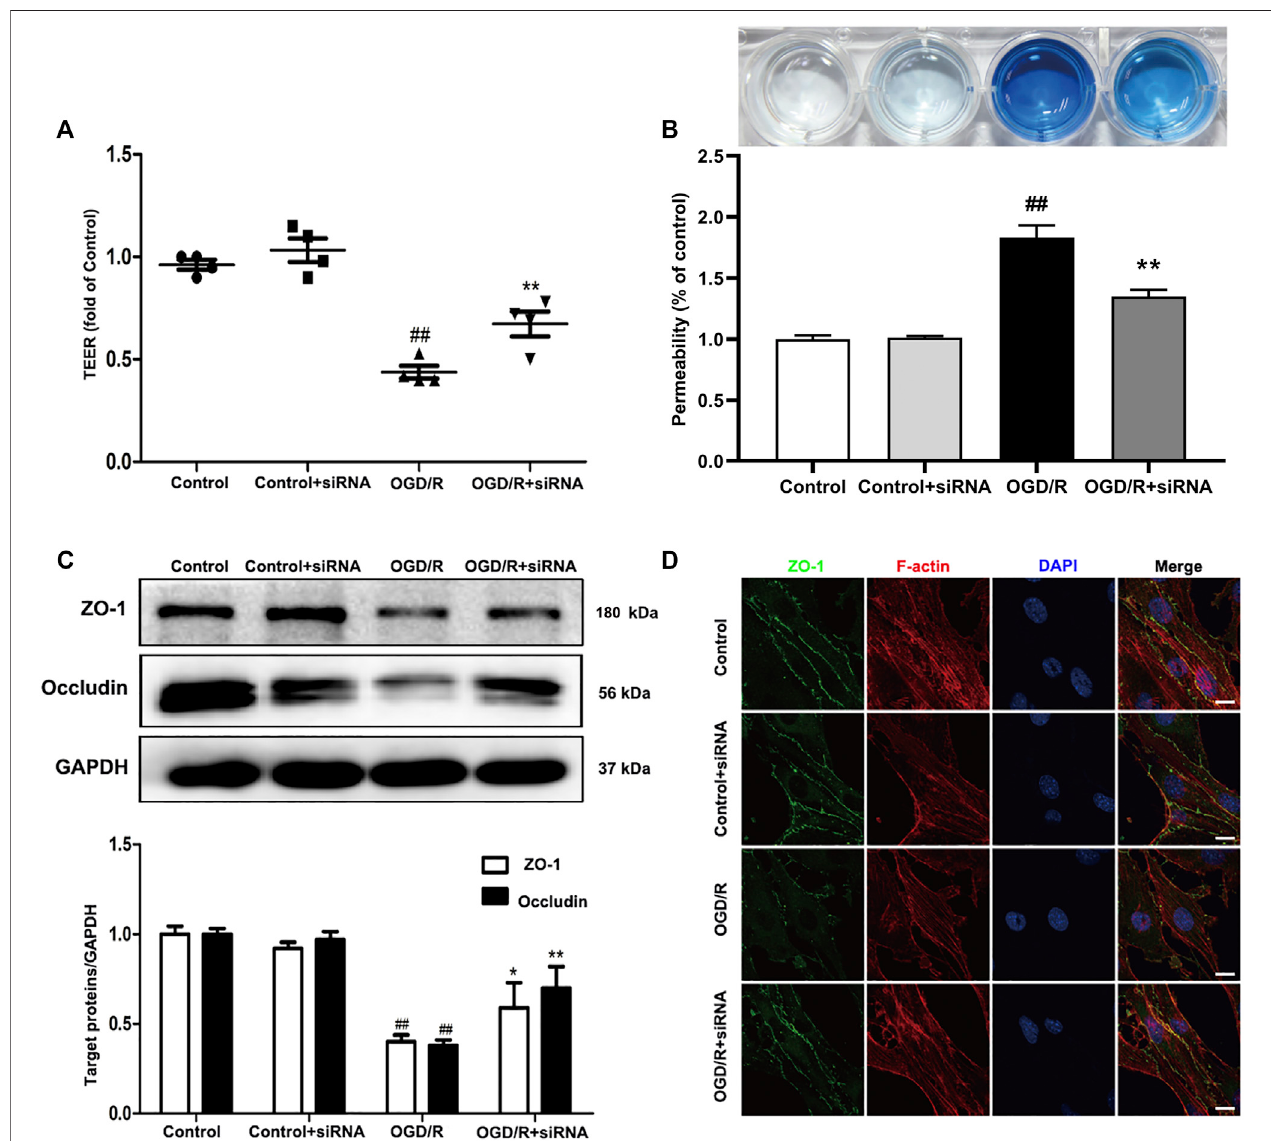
FIGURE 8 | Effects of YAP-siRNA on endothelial barrier injury induced by OGD/R. bEnd.3 cells were treated with YAP-siRNA and subsequently exposed to 6 h of OGD and 6 h of reoxygenation. (A) and (B) A barrier-protective effect for YAP-siRNA was detected using TEER and EB assays. (C) Representative western blots and quantitativeanalyses forZO-1andoccludinexpressionlevels. (D) Representativemicroscopeimages (based onimmuno fl uorescenceanalyses)ofZO-1(green), F-actin (red), and DAPI-stained nuclei (blue). Scale bar (cid:1) 20 µm. Dataareexpressed asthe mean ± SD, n (cid:1) 3. ## p < 0.01 vs . Control group, * p < 0.05, ** p < 0.01 vs . OGD/ R